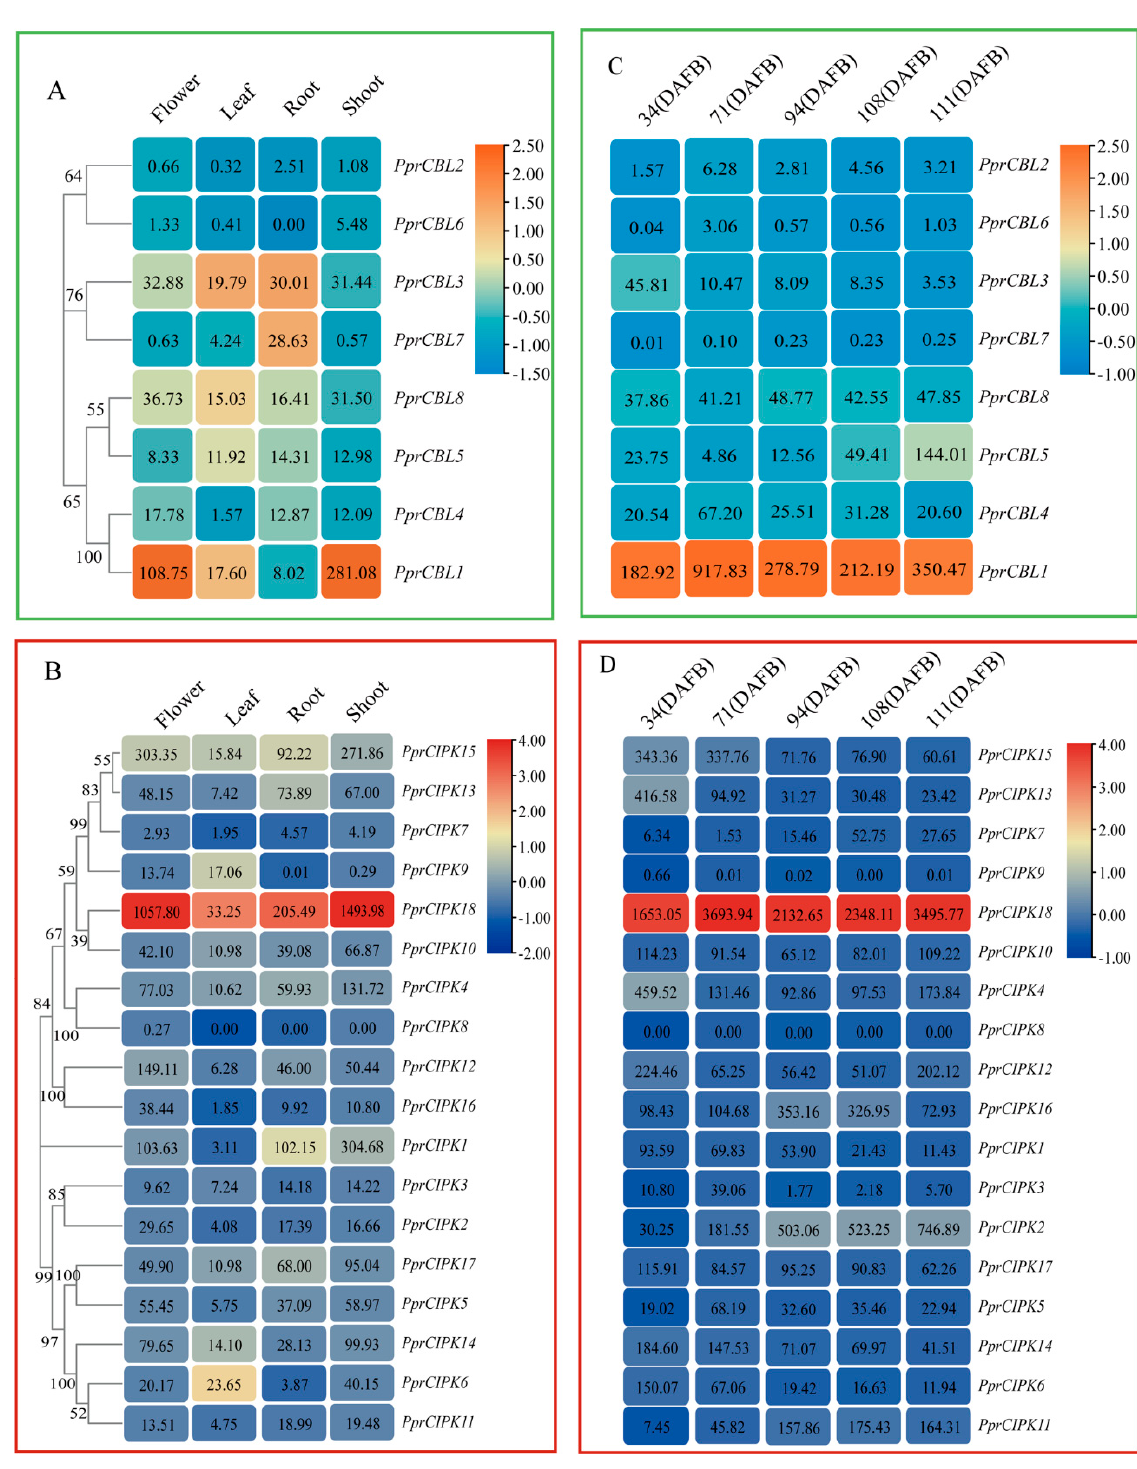
Figure 4. Heatmap analysis of spatiotemporal expression patterns of CBL and CIPK gene members in peach. ( A , B ) CBL and CIPK expression profiles in flowers, leaves, roots and shoots. ( C , D ) CBL and CIPK expression patterns in peach at different developmental stages. The value given in the box represents the original gene expression levels (TPM), and the indicator ranges in the upper right corner represent the range of the values after log transformation and normolization.